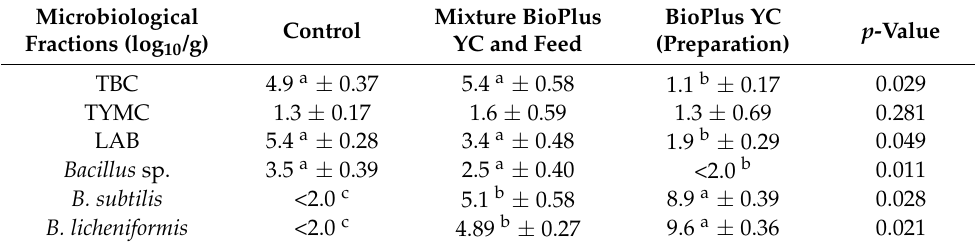
Table 3. Composition of microbiological fractions in